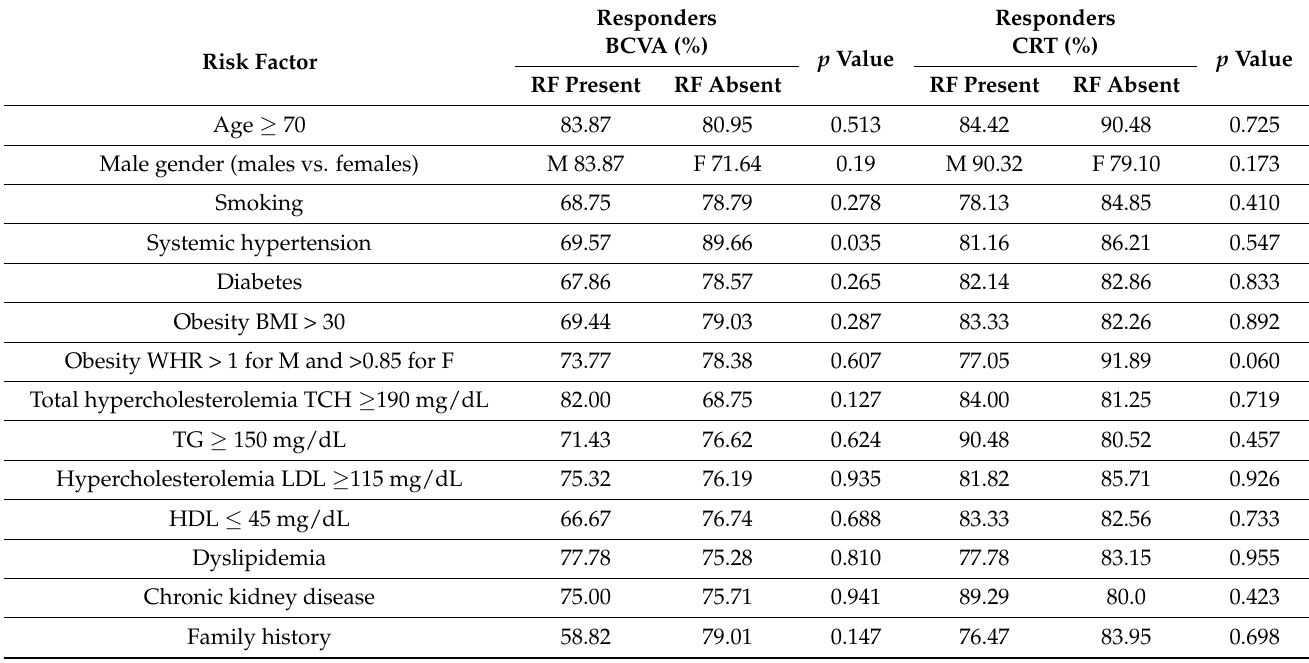
Table 5. Difference between percentage of responders to treatment at 12 months according to the presence or absence of a specific risk factor. p values refer to statistical significance of that difference between patients with risk factor present versus patients with risk factor absent.